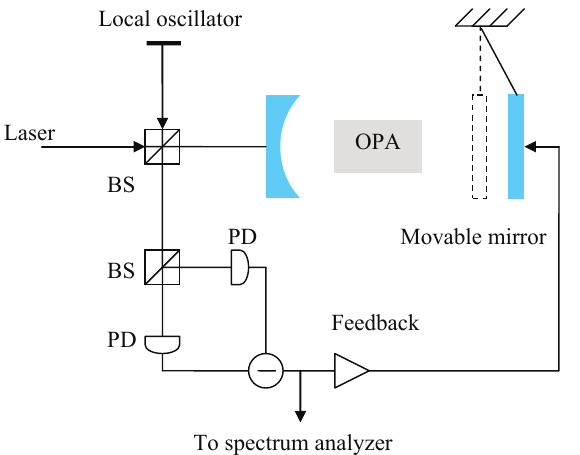
Figure 1. Sketch of the studied optomechanical system with a feedback loop. An external laser is sent into the optical cavity containing a degenerate OPA. With the help of a beam splitter and a 100% reflecting mirror, the laser also provides the local oscillator for the homodyne measurement of the outgoing light from the cavity. After detecting the cavity output by homodyne measurement, a part of the result of the homodyne measurement is fed back to control the motion of the oscillating mirror. The OPA is driven by coherent light (not shown). BS: 50:50 beamsplitter, PD: photodetector. Here, c ( c † ) is the bosonic annihilation (creation) operator of the cavity mode satisfying [ c , c † ] = 1. G = ω c 0 L